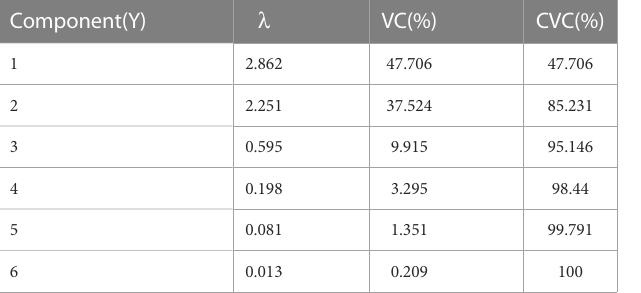
TABLE 5 The eigenvalues and variance contribution rate of each index correlation